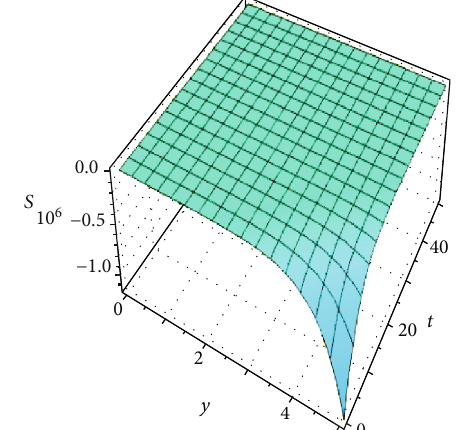
vs. space y and time t S